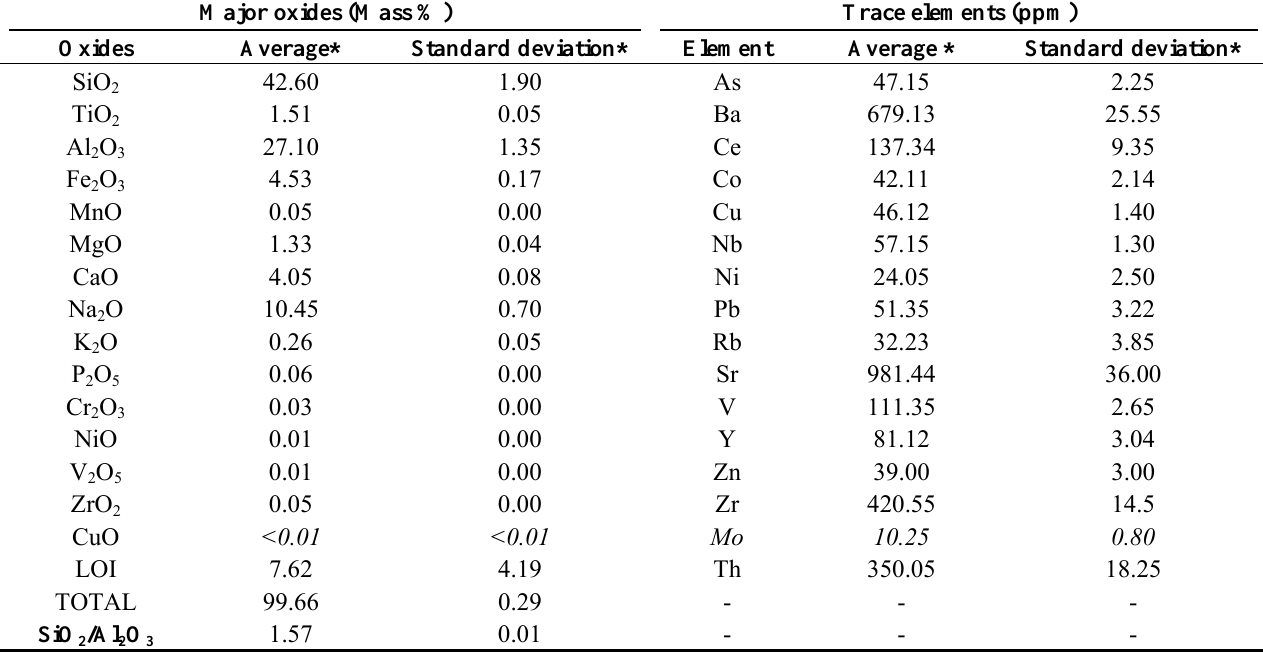
* means standard deviation of triplicate